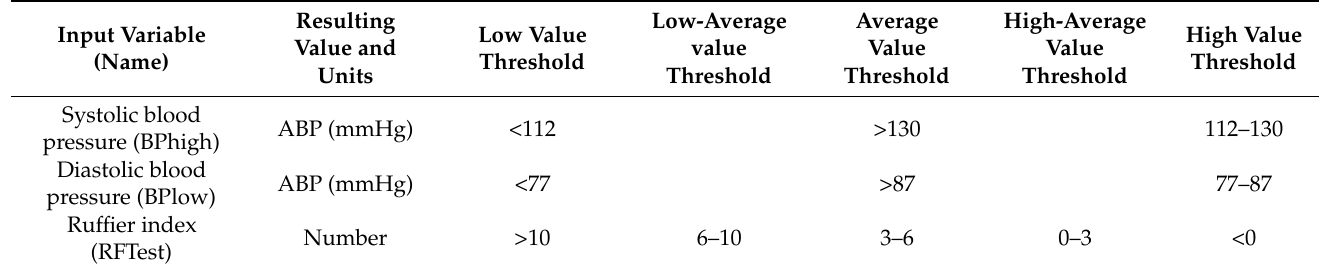
Table 3. Measured parameters and values for the cardiovascular system evaluation in the proposed expert system.